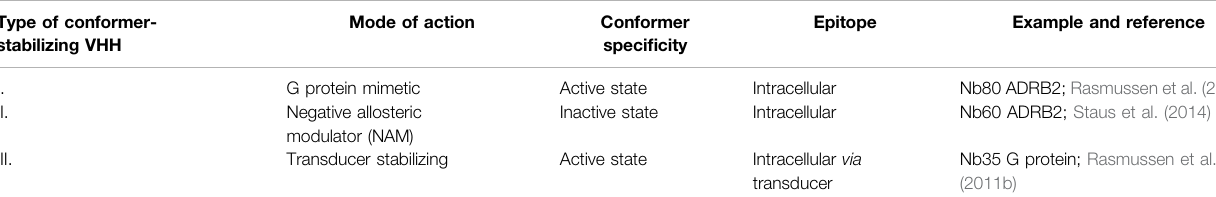
TABLE 1 | Conformer-stabilizing VHH (ConfoBody) classi fi cation used in this review article. Type of conformer- stabilizing VHH